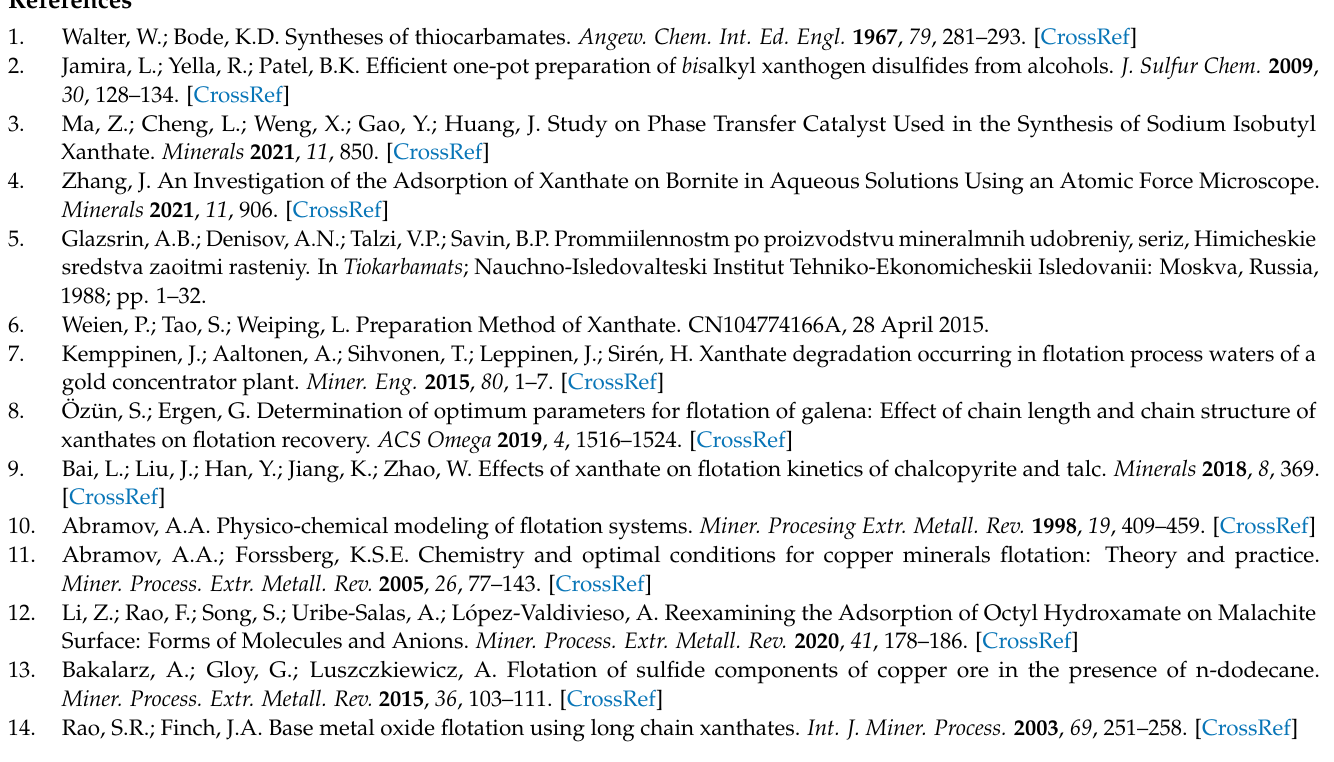
isobutyl thiocarbamate, Figure S7: FTIR spectrum of N -isopentyl- O -isobutyl thiocarbamate, Figure S8: FTIR spectrum of N -cyclopentyl- O -isobutyl thiocarbamate, Figure S9: FTIR spectrum of N -cyclohexyl- O -isobutyl thiocarbamate, Figure S10: FTIR spectrum of N , N -dipropyl- O -isobutyl thiocarbamate, Figure S11: FTIR spectrum of N -propyl- O -ethoxy thiocarbamate, Figure S12: FTIR spectrum of N , N -dipropyl- O -ethoxy thiocarbamate, Figure S13: 13 C NMR spectra of N -propyl- O -isobutyl thio- carbamate, Figure S14: 13 C NMR spectra N -sec butyl- O -isobutyl thiocarbamate, Figure S15: 13 C NMR spectra of N -isopropyl- O -isobutyl thiocarbamate, Figure S16: 13 C NMR spectra of N -isobutyl- O -isobutyl thiocarbamate, Figure S17: 13 C NMR spectra of N -isopentyl- O -isobutyl thiocarbamate, Figure S18: 13 C NMR spectra of N -cyclopentyl- O -isobutyl thiocarbamate, Figure S19: 13 C NMR spec- tra N -cyclohexyl- O -isobutyl thiocarbamate, Figure S20: 13 C NMR spectra of N , N -dipropyl- O -isobutyl thiocarbamate, Figure S21: 13 C NMR spectra of N , N -dibutyl- O -isobutyl thiocarbamate, Figure S22: 13 C NMR spectra of N , N -dipropyl- O -isobutyl thiocarbamate, Figure S23: GC-MS chromatogram for N -isobutyl- O -isobutyl thiocarbamate, Figure S24: GC-MS chromatogram for N -butyl- O -isobutyl thiocarbamate, Figure S25: GC chromatogram for N -ethyl- O -isobutyl thiocarbamate (method B), Figure S26: GC chromatogram for N -ethyl- O -isobutyl thiocarbamate (method A), Figure S27: GC chromatogram for N -ethyl- O -isobutyl thiocarbamate (method C), Table S1. 1 H and 13 C NMR data, and results of elemental analysis of synthesized N -alkyl, N , N -dialkyl and N -cycloalkyl- O -isobutyl thiocarbamates, Table S2: FTIR and MS data of N -alkyl, N , N -dialkyl and N -cycloalkyl- O -isobutyl thiocarbamate, Table S3: 1 H and 13 C NMR data, and results of elemental analysis of O , O -dialkyl dixanthates intermediates, Table S4: FTIR and MS data of O , O -dialkyl dixanthates